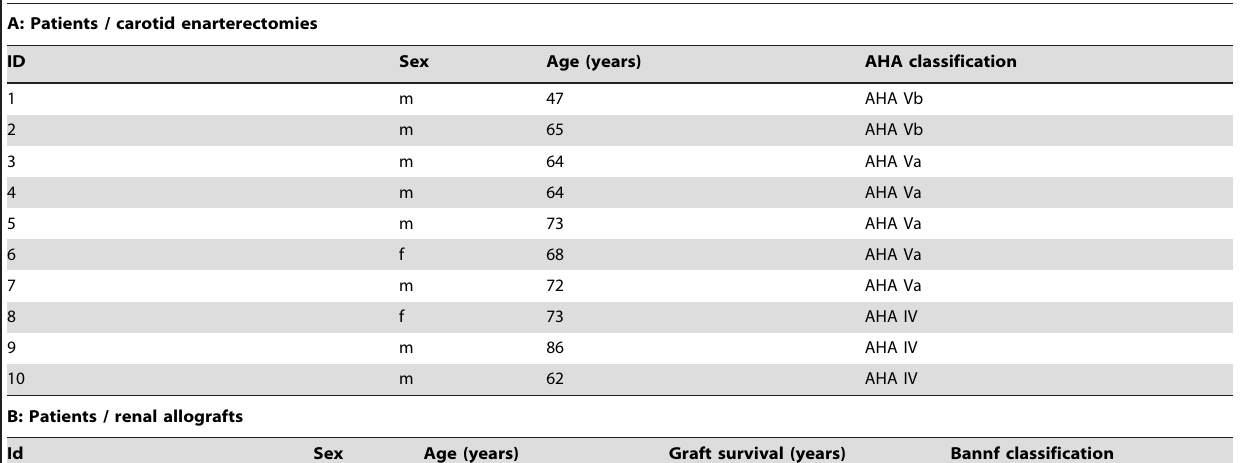
A: Patients / carotid enarterectomies